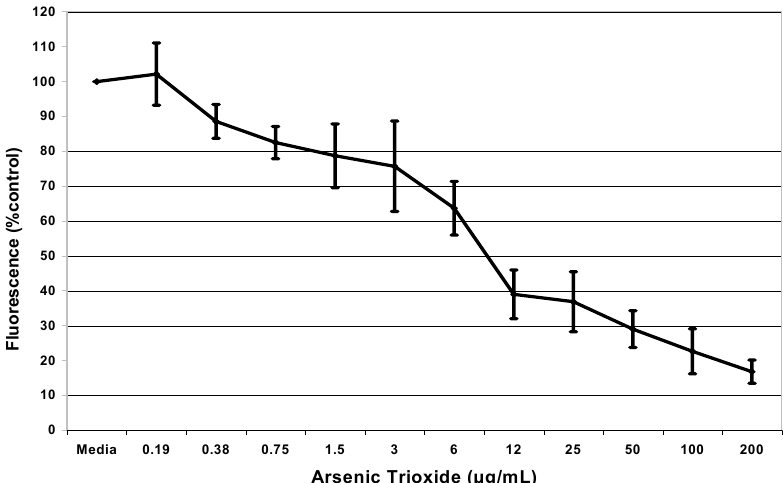
Figure 1. Cytotoxicity of arsenic trioxide to HaCaT cells. Cells were seeded in 96 well plates (20,000 cells / well) and different doses of arsenic trioxide were added in triplicate samples. Each point represents the mean of three samples expressed as percent control.